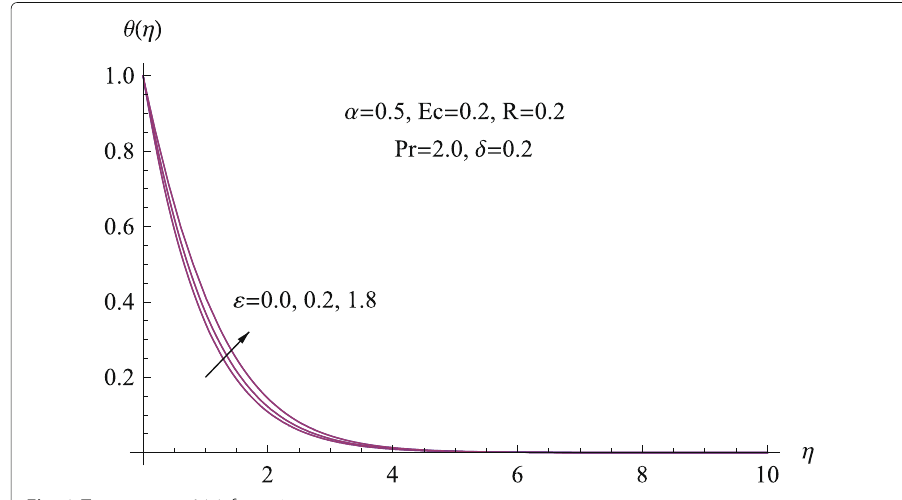
For returning to the work at hand and seeking to measure the impact of all physical parameters governing the Williamson fluid flow on both the local skin-friction coefficient − 1 1 1 2 2 Re x Cf x and the local Nusselt number Re x Nu x , one needs to calculate the data which 2 appear in Table 2. Of particular interest, introduced here are the Eckert number Ec , the viscosity parameter α , and the non-Newtonian Williamson parameter δ , in which they result in a diminishing behavior for both the local skin-friction coefficient and the local Nusselt number. On the other hand, an augmentation behavior in the local Nusselt num- ber is noted from this study for increasing both the thermal conductivity parameter ε and the thermal radiation parameter R , but a reduction trend was for the local skin-friction coefficient.